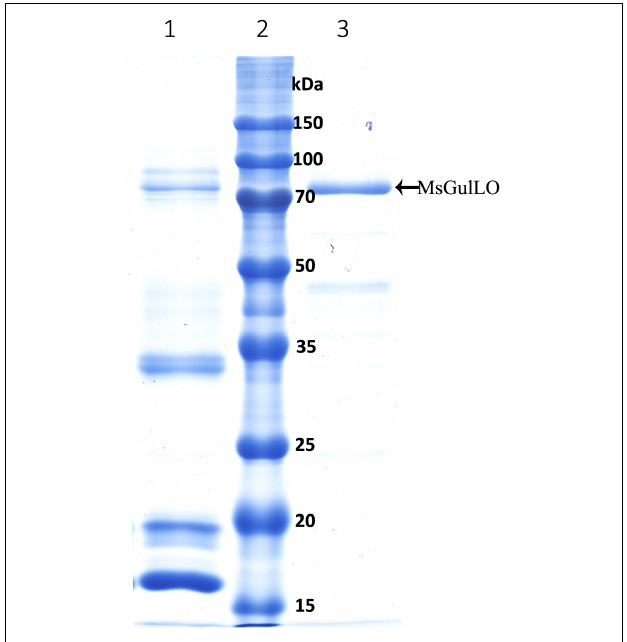
FIGURE 5 | SDS–PAGE of M. sempervirens nectar proteins and isolated MsGulLO. Lane 1, MS nectar proteins; lane 2 molecular weight markers; lane 3, Isolated